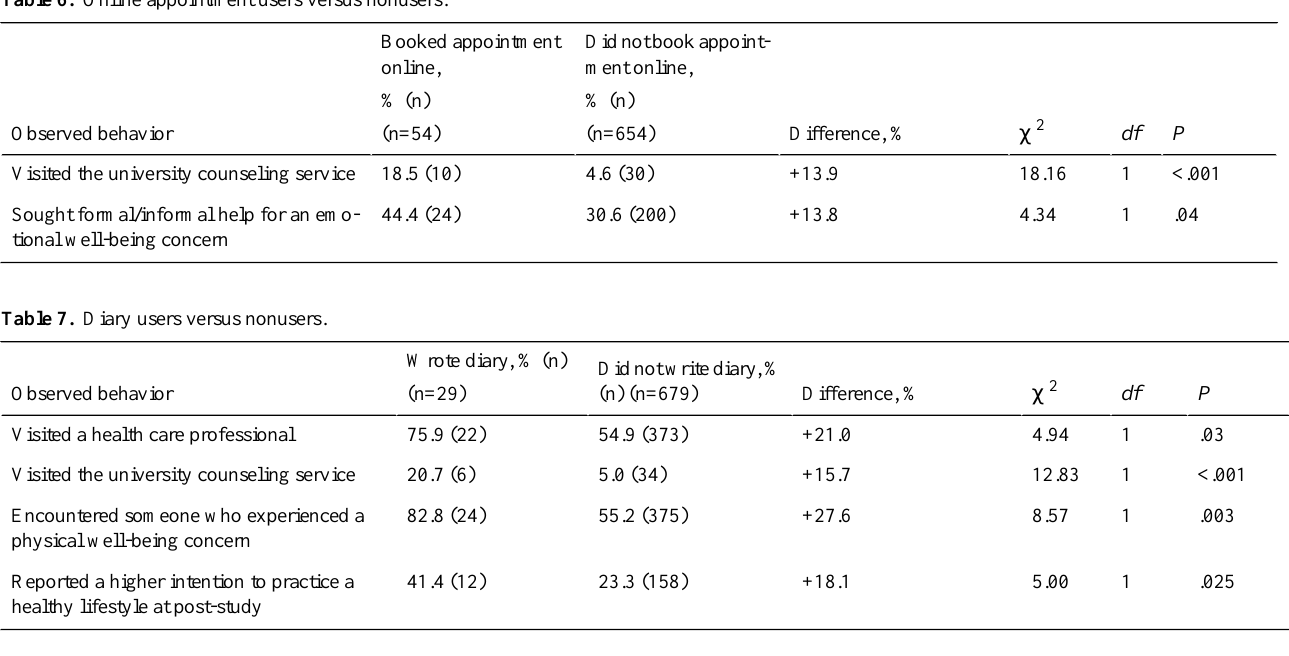
Table 6. Online appointment users versus nonusers.